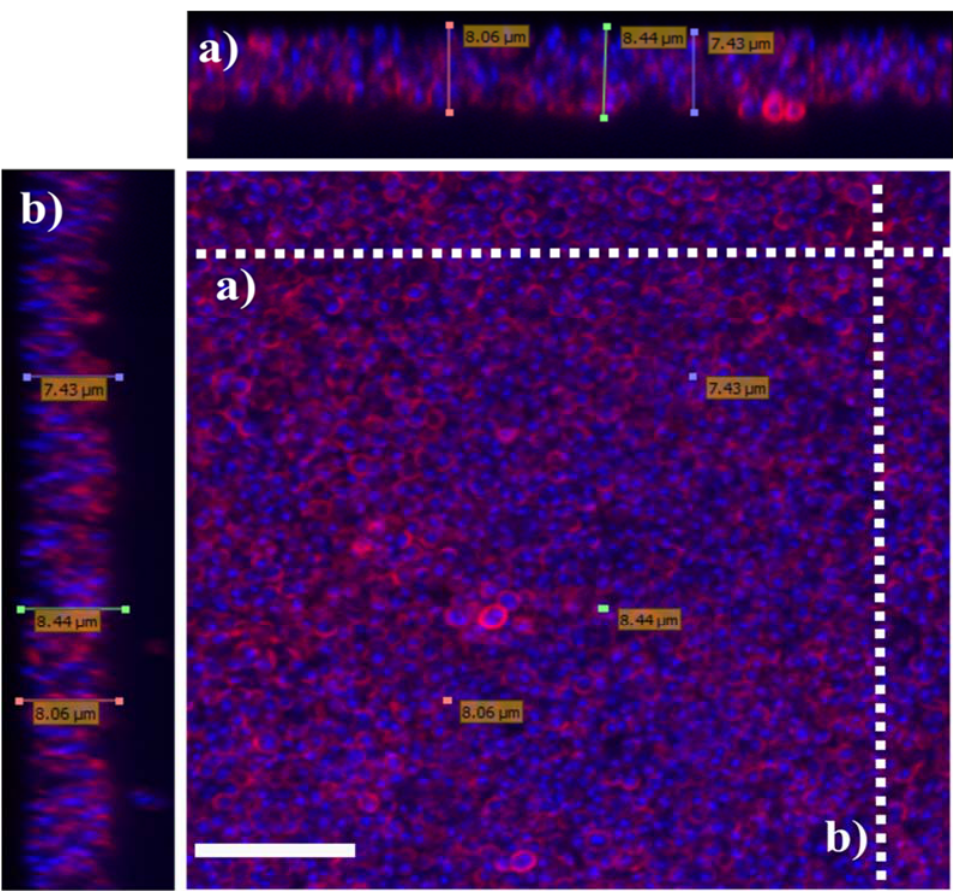
Figure 2. The three-dimensional structure of S. aureus biofilms visualized with a confocal microscope. S. aureus biofilms were cultured in tryptic soy broth for 48 hours, fixed with 4% paraformaldehyde and treated with wheat germ agglutinin (WGA, red) to stain n-acetylglucoseamine component of polysaccharide and DAPI (blue) to stain the bacteria nuclear material, followed by confocal microscopy z-stack projection that moved through 111 slices across the cell. (a) Horizontal cross-section of biofilms and (b) Vertical cross-section of biofilms. White scale bar is 7.5 µ m. The approximate thickness of